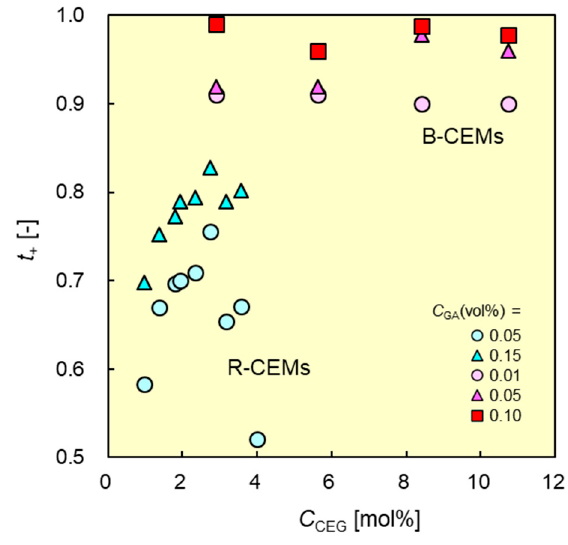
Figure 8. Dynamic state transport numbers t + of B-CEMs and R-CEMs vs. C CEG of cation-exchange groups in copolymers. Red and blue symbols denote the data of B-CEMs and R-CEMs, respectively.